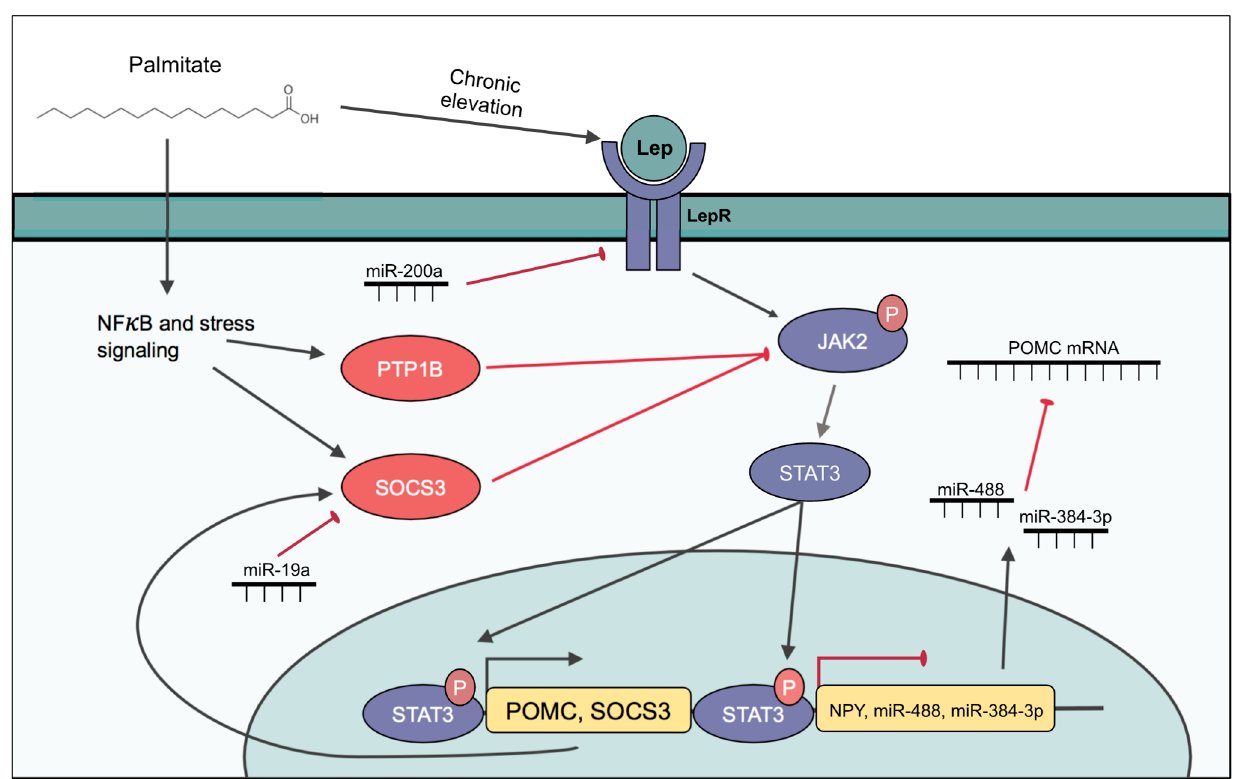
Figure 2. Hypothalamic leptin signaling. Leptin binds to LepR on the cell membrane, inducing the phosphorylation of JAK2, which in turn phosphorylates STAT3, and causes the translocation of STAT3 to the nucleus. In the nucleus, p-STAT3 induces the expression of Pomc and Socs3 and represses the expression of Npy , miR-488, and miR-384-3p. SOCS3 negatively feeds back to inhibit JAK2 phosphorylation. miR-488 and miR-384-3p target the 3 ′ -UTR of Pomc mRNA and inhibit its expression. miR-200a targets the 3 ′ -UTR of LepR , inhibiting its expression and reducing leptin sensitivity. Socs3 is targeted by miR-19a and can enhance JAK2-STAT3 signaling. Palmitate directly induces leptin resistance by inducing inflammation and ER stress, resulting in the activation of PTP1B and SOCS3. Excess palmitate can also induce leptin resistance by chronically increasing circulating leptin, leading to overactivation of the signaling pathway.